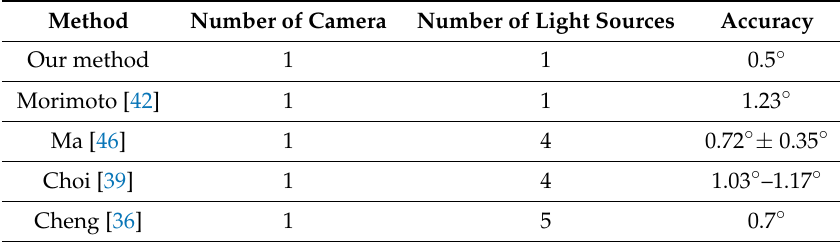
Table 3. Comparison of experimental accuracy of different